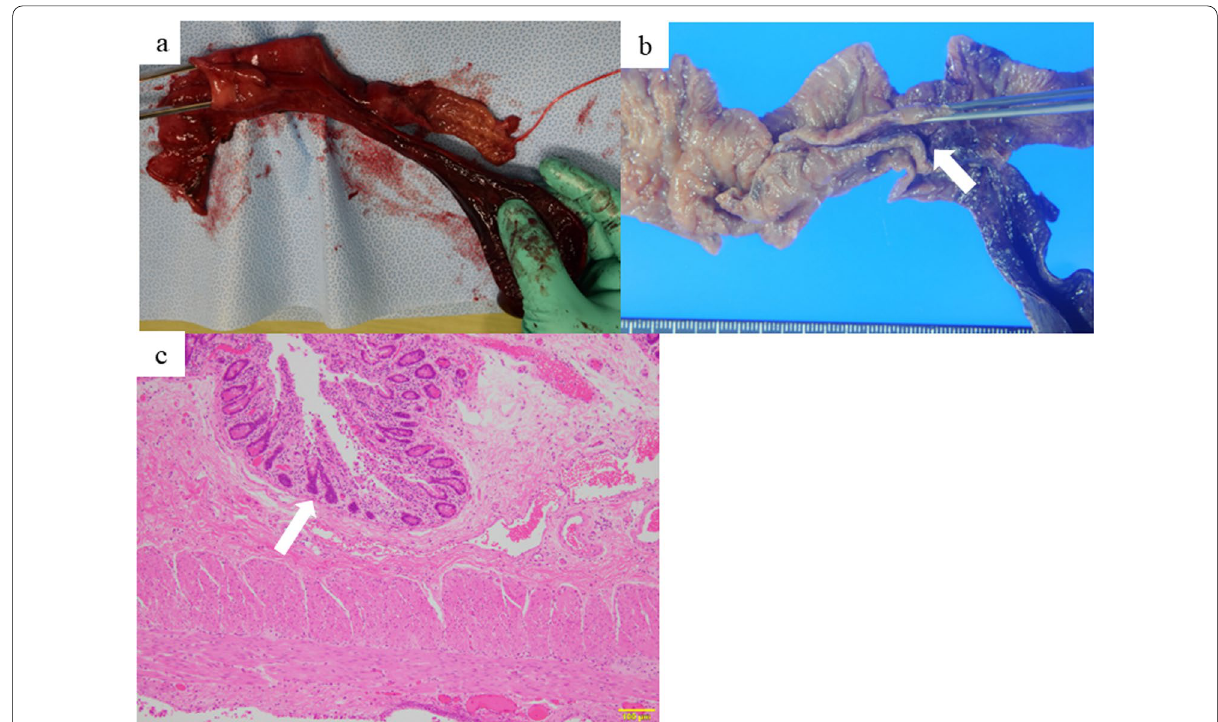
Fig. 3 Excised specimen and pathological findings. a , b The overall picture of the intestinal duplication, partially protruding like a diverticulum and showing necrosis due to twisting. b The inner surface of the intestinal duplication was covered with intestinal mucosa. (arrow). c Hematoxylin–eosin staining of resected specimen. The inner surface of the intestinal duplication was covered with intestinal epithelium